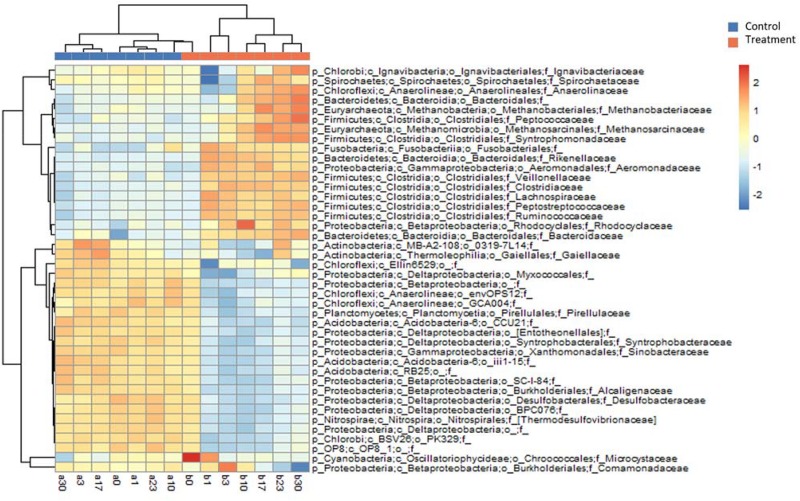
Heatmap diagram showing relative abundances of the top 25 families selected from Control and Treatment (a total of 42 families). Upper dendrogram shows community similarity among samples and left dendrogram depicts clustering of families by co-occurrence.